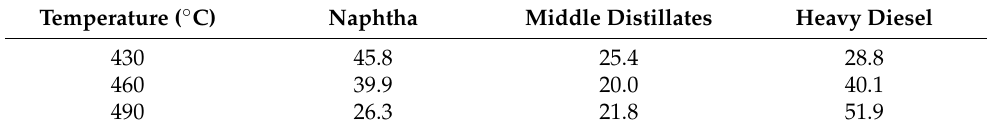
Figure 5. Simulated distillation curves of pyrolysis oils of PT-Film pyrolyzed at different temperatures. Table 11. Distillation fractions of pyrolysis oils of PT-Film pyrolyzed at different temperatures. Temperature ( ◦